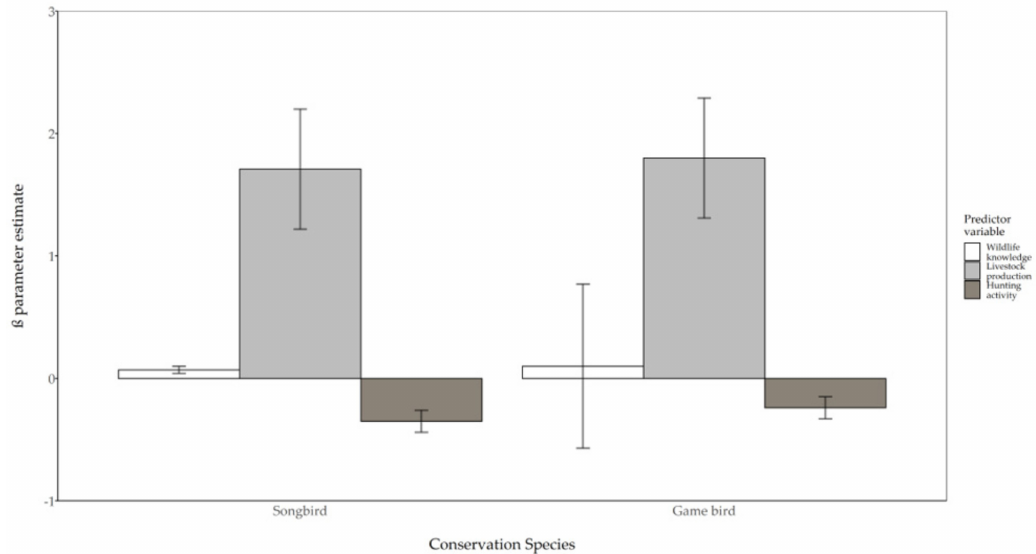
Figure 3. Effects of wildlife knowledge (white bars), livestock production (light gray bars), and hunting activity (dark gray bars) on likelihood to delay prairie hay harvest for the purposes of songbird and game bird conservation by ranchers in the Holt and Cherry counties, Nebraska, USA, 2019. β parameter estimates with standard errors for songbird conservation depict directional transition from little to great wildlife knowledge ( χ 2 = 7.60; odds ratio = 1.08; 95% CI = 1.02–1.14; p < 0.01; Cram é r’s V = 0.34), non-livestock producers to livestock producers ( χ 2 = 12.10; odds ratio = 5.53; 95% CI = 2.11–14.50; p < 0.01; Cram é r’s V = 0.27), and no hunting activity to multiple hunting activities ( χ 2 = 14.89; Odds ratio = 0.71; 95% CI = 0.59–0.84; p < 0.01; Cram é r’s V = 0.18). β parameter estimates with standard errors for game bird conservation depict directional transition from little to great wildlife knowledge ( χ 2 = 13.01; odds ratio = 1.11; 95% CI = 1.05–1.17; p < 0.01; Cram é r’s V = 0.36), non-livestock producers to livestock producers ( χ 2 = 13.29; odds ratio = 6.05; 95% CI = 2.31–15.86; p < 0.01; Cram é r’s V = 0.27), and no hunting activity to multiple hunting activities ( χ 2 = 6.91; odds ratio = 0.78; 95% CI = 0.65–0.94; p < 0.01; Cram é r’s V =